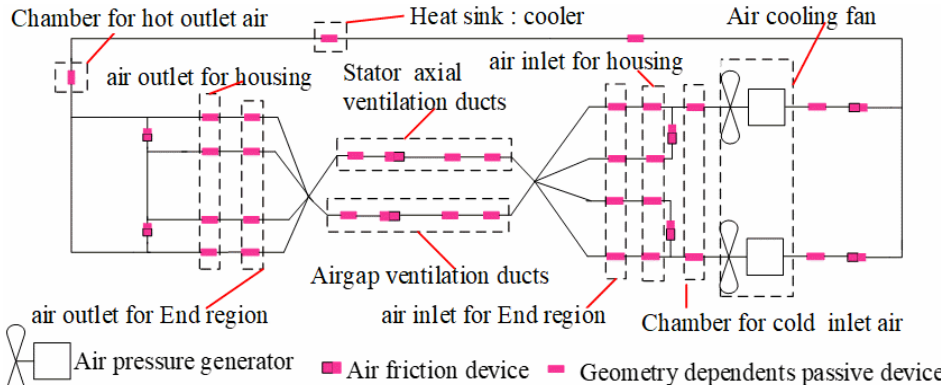
Figure 7. Proposed airflow model of the FACAVS HSPMSM.